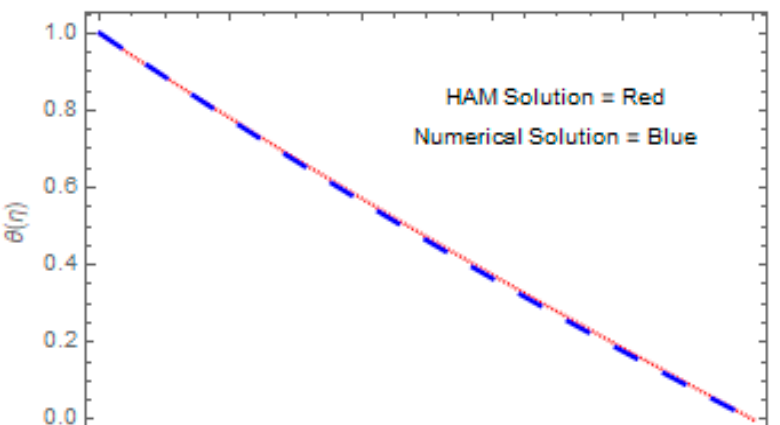
Figure 16. Comparison for column-shaped nanoparticles.